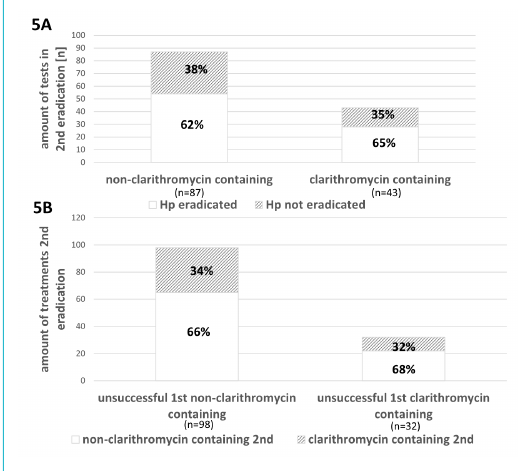
Figure 5: Second-line Helicobacter pylori eradication therapies and their success (between the years 2004 and 2018). 5A: Eradi- cation success after second-line therapies containing clar- ithromycin- vs non-clarithromycin-containing regimens. 5B: Sec- ond-line eradication therapies after different failed first-line regimens. Hp: Helicobacter